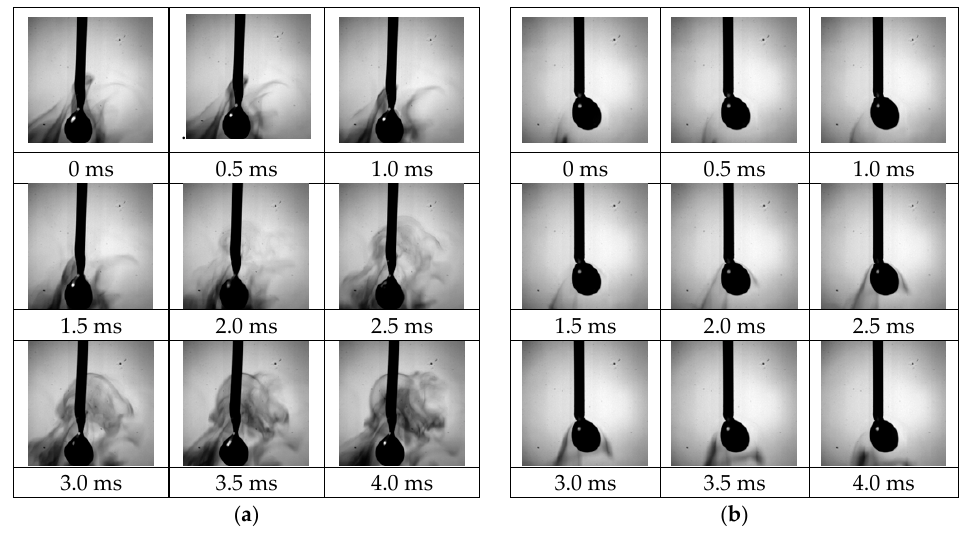
Figure 10. High ‐ speed images during laser melting: ( a ) AZ31 ‐ A; ( b ) AZ31 ‐ B.